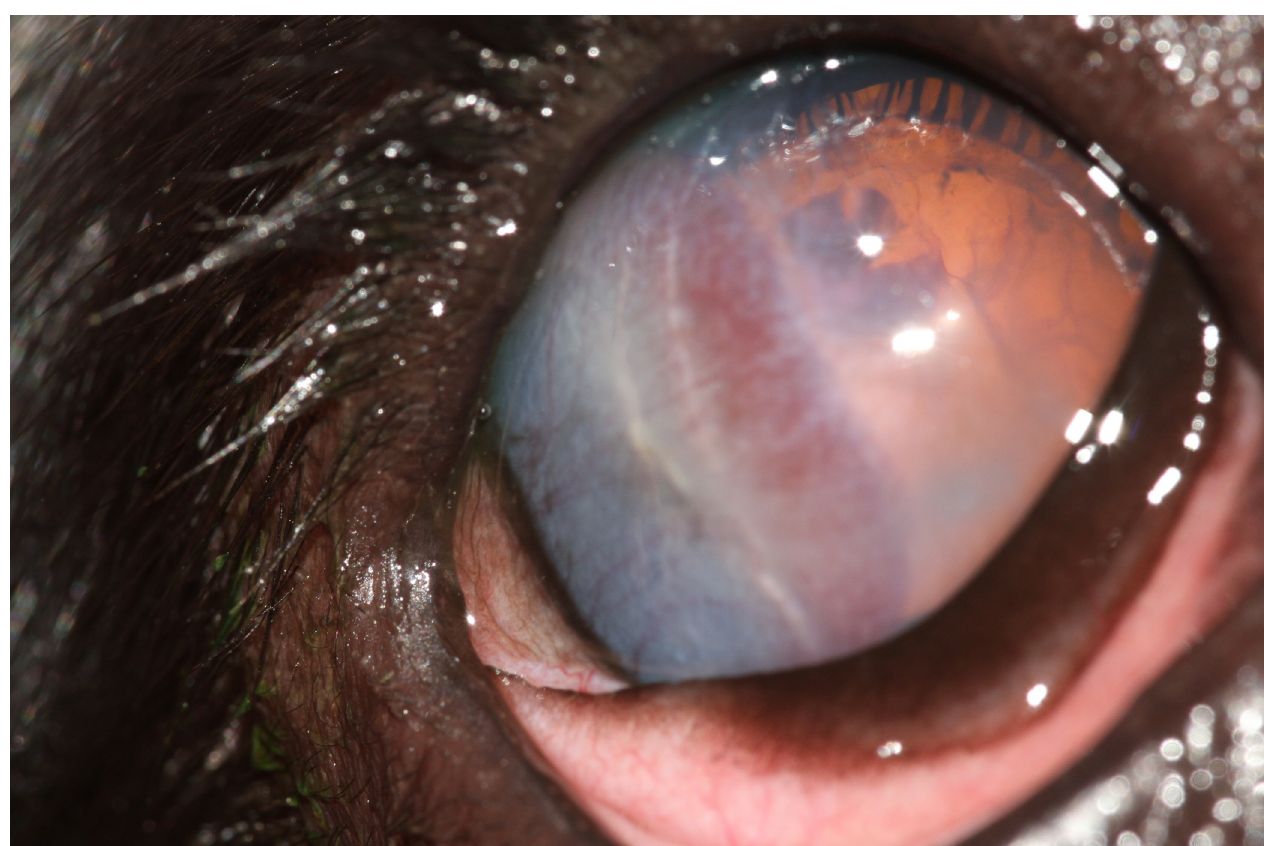
Fig 4. Ocular defects associated with affected ECS. Showing corneal and lenticular